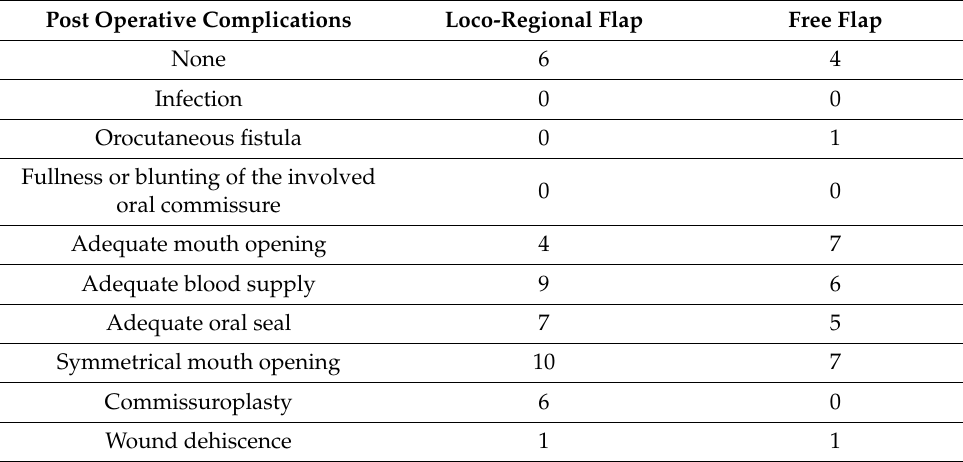
Table 4. Post operative